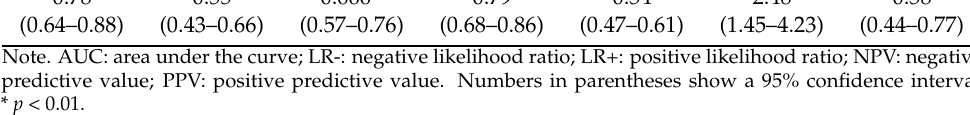
Table 4. Screening properties of the SUNFRAIL tool for cutoff >2.